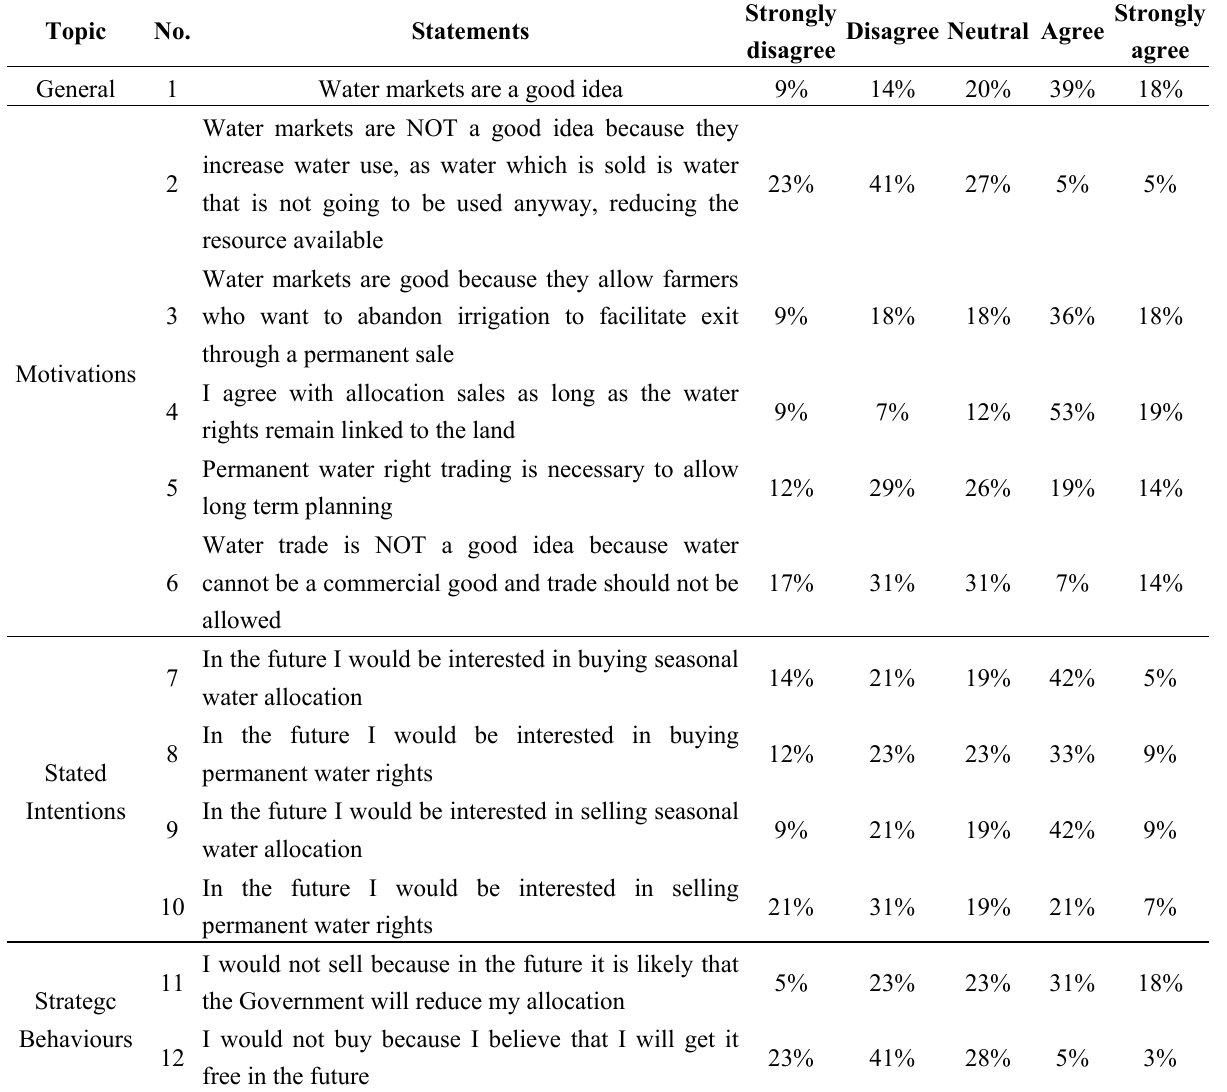
Table 2. Stakeholders’ perceptions of and attitudes towards water markets a